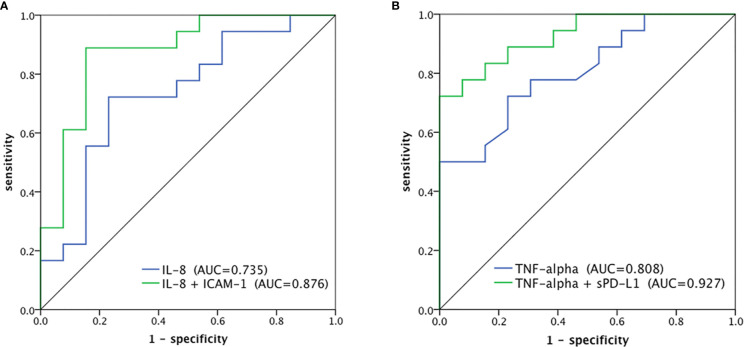
ROC curves to predict objective response of CCRT. (A) IL8 alone and IL-8 in combination with ICAM-1, (B) TNF-α alone and TNF-α in combination with sPD-L1.